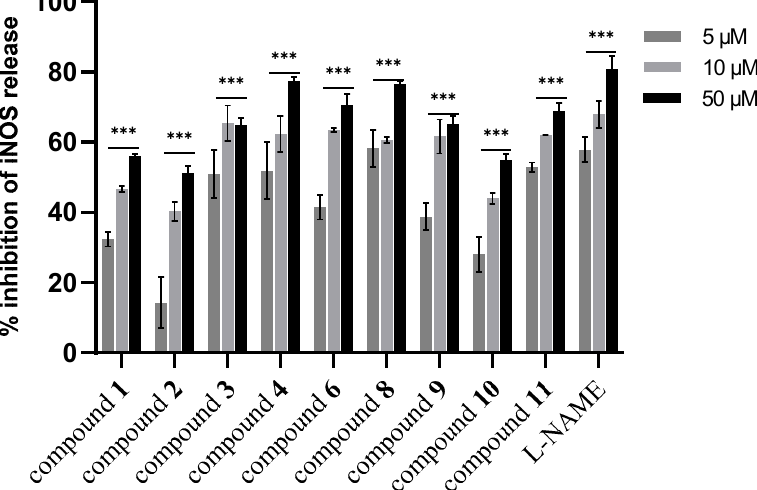
Figure 5. Effect of isolated compounds from aerial parts of Dionysia diapensifolia on iNOS expression in J774A.1 macrophages (n = 3). Data are expressed as mean ± S.E.M.; *** denotes p < 0.001 vs. LPS (1 µg/mL). L-NAME (5, 10, and 50 µM) was used as a positive control.